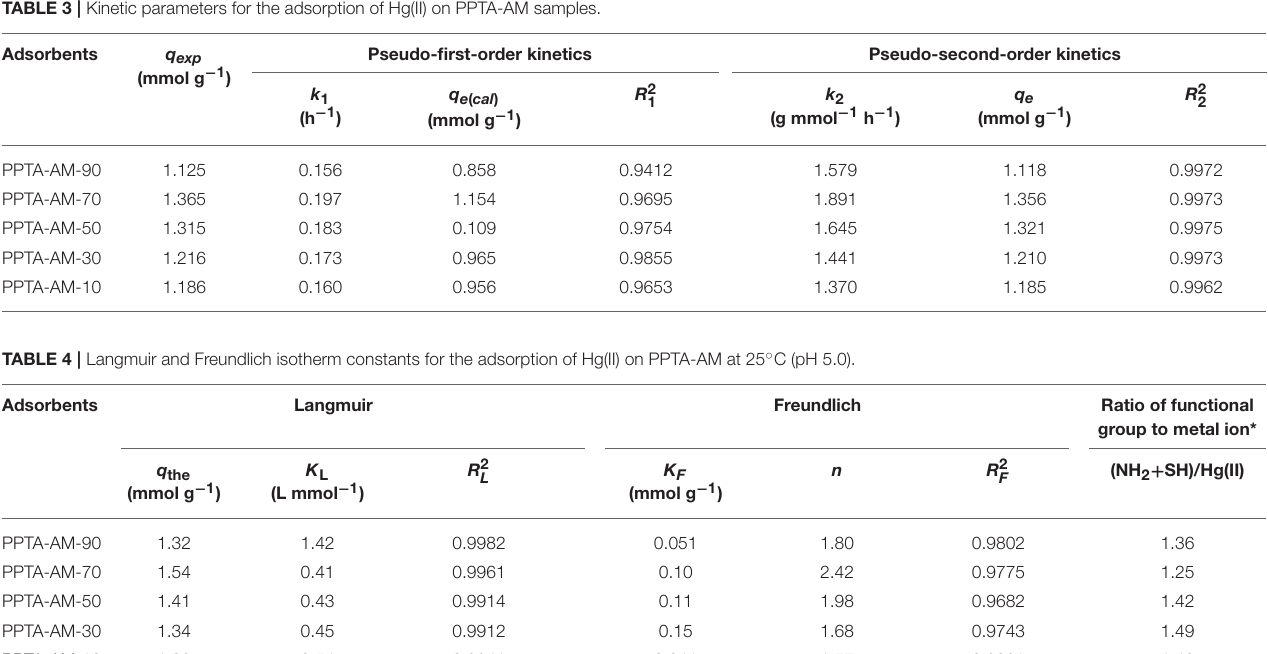
TABLE 3 | Kinetic parameters for the adsorption of Hg(II) on PPTA-AM samples. Adsorbents